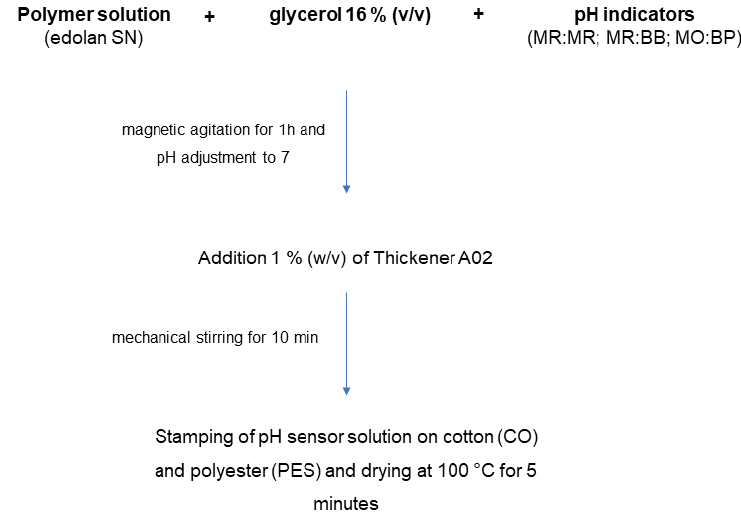
Figure 1. Schematic representation for the preparation of pH-sensitive formulations and application on cotton and polyester knits.